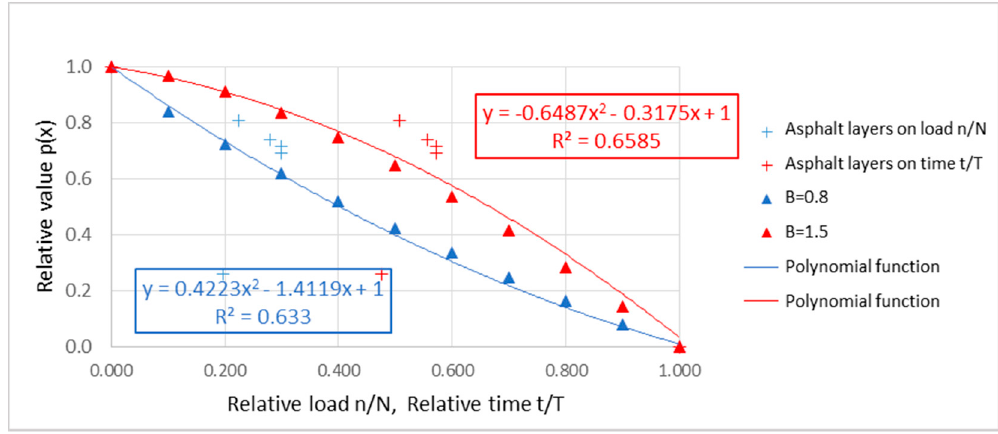
Figure 12. Degradation of the modulus of elasticity depending on the time t/T and load n/N (20.01–30.00 °C).